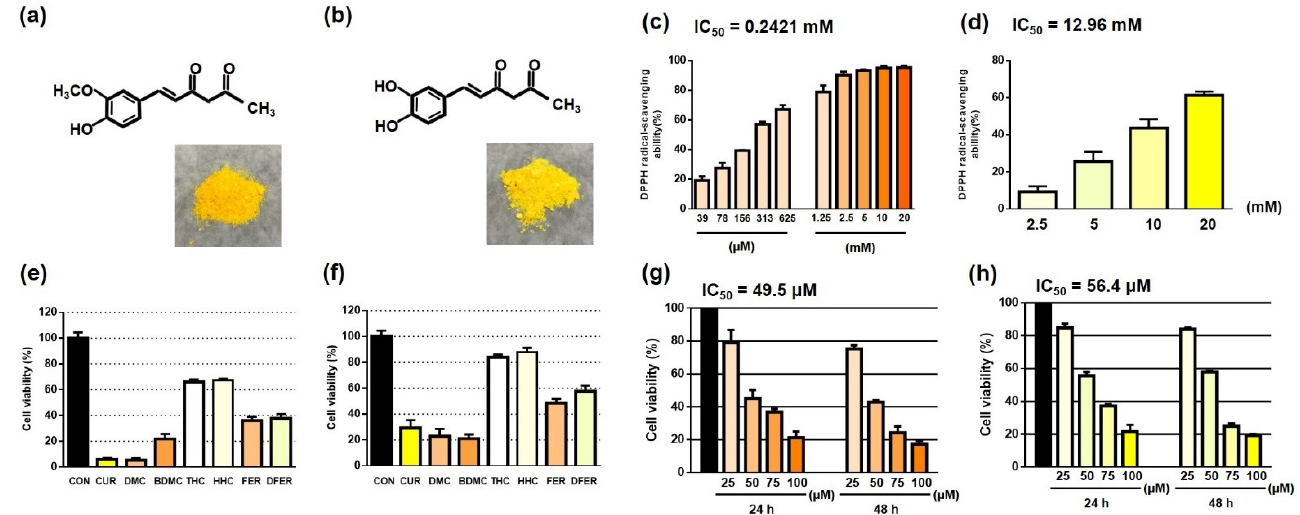
Figure 1. FER and DFER exhibit an antiproliferative effect on colon cancer HCT116 cells. ( a , b ) Structural configuration and appearance of FER and DFER. ( c , d ) DPPH radical scavenging ability and IC50 of FER and DFER. ( e , f ) Cell viability of HCT116 after being treated by curcumin and its analogs or degradants, at the concentration of 100 or 50 μM for 24 h. ( g , h ) Cell viability of HCT116 after being treated by FER or DFER at various concentrations for 24 or 48 h.